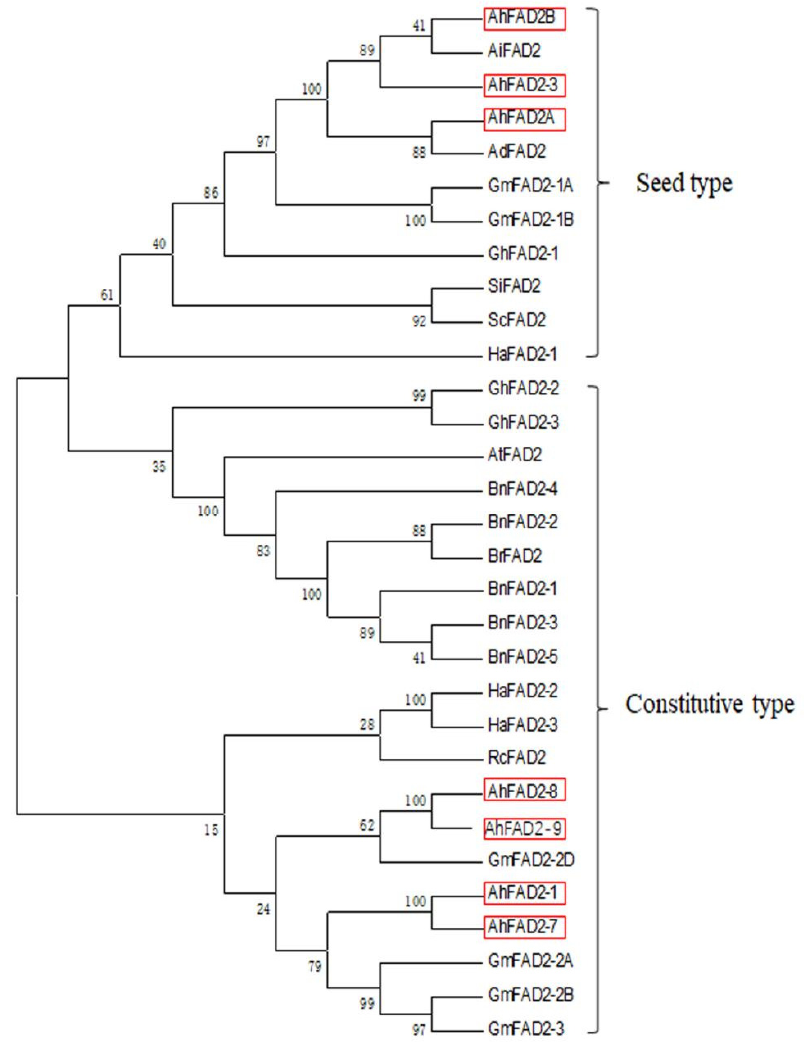
Figure 4. Phylogenetic tree analysis of plant microsomal oleate desaturases: Arabidopsis thaliana (AtFAD2, L26296), Arachis duranensis (AdFAD2, AF272951), Arachis ipaensis (AiFAD2, AF272952), Bras- sica rapa (BrFAD2, AJ459107), Brassica napus (BnFAD2-1, FJ907397; BnFAD2-2, FJ907398;